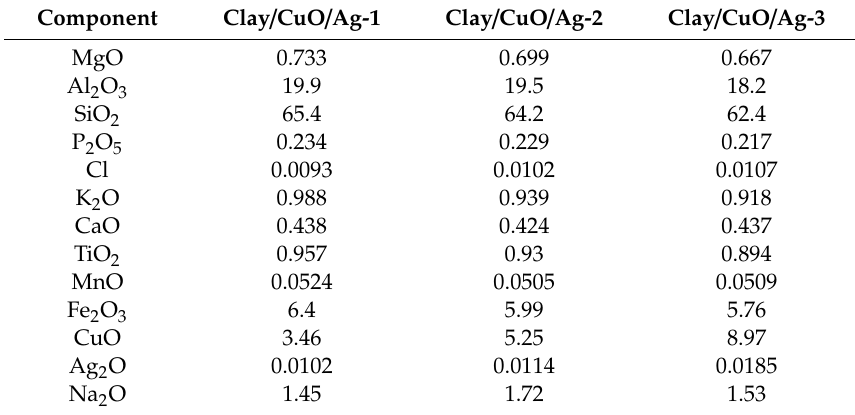
Table 3. X-ray fluorescence (XRF) analysis of the components of clay / CuO / Ag samples: clay / CuO / Ag-1, clay / CuO / Ag-2 and clay / CuO / Ag-3 nanocomposites (in wt.%).